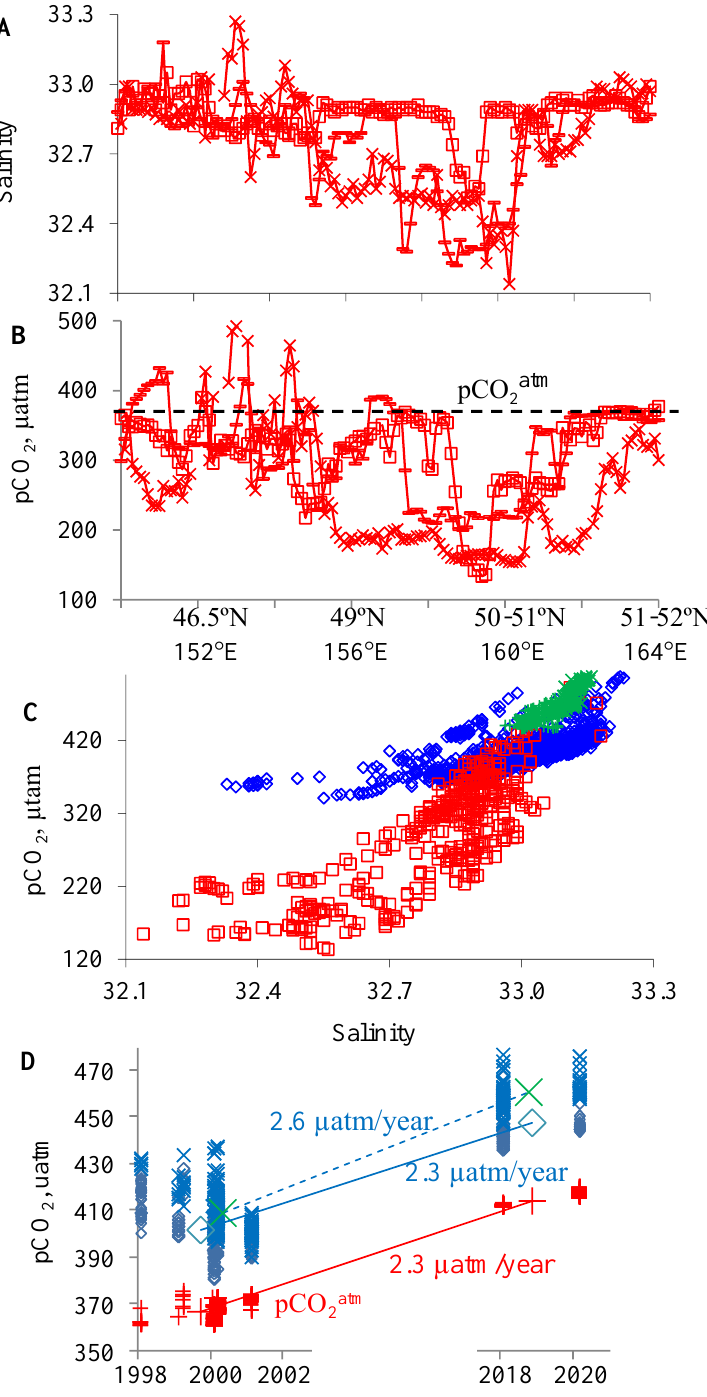
Figure 8. The salinity ( A ) and pCO 2 ( B ) distribution in the western subarctic North Pacific in summer (See Figure 2b) (red squares—13–15.06.1995, red strokes—16–18.07.1998, red crosses’—01–03.07.1999) and pCO 2 versus ( C ) (blue diamonds—winter (1998–2003, 2013), red squares—summer (1995, 1998, 1999), green crosses—winter 2018 and winter 2020) and change in the seawater (diamonds—water with a salinity of 33.00–33.05, crosses—water a salinity of 33.05–33.10) and atmospheric pCO 2 in the study area ( D )).